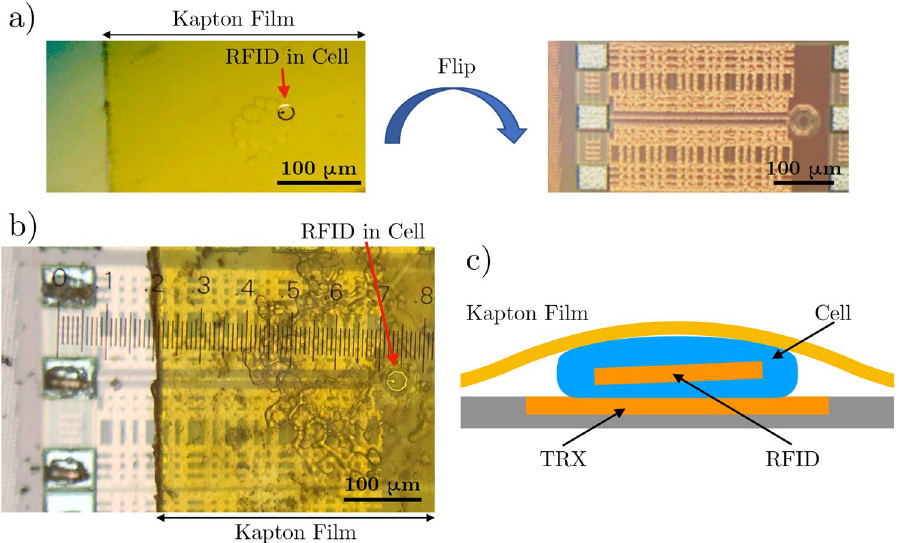
Figure 4. Cell and RFID alignment onto a transceiver. ( a ) Using the flip chip bonder, flip a Kapton film with a RFID in a cell onto the transceiver structure on the integrated circuit chip. ( b ) RFID is aligned in the transceiver loop, and probe pads are uncovered for electrical measurements. ( c ) Cross section schematic shows that the Kapton film pins the cell and intracellular RFID within the transceiver detection